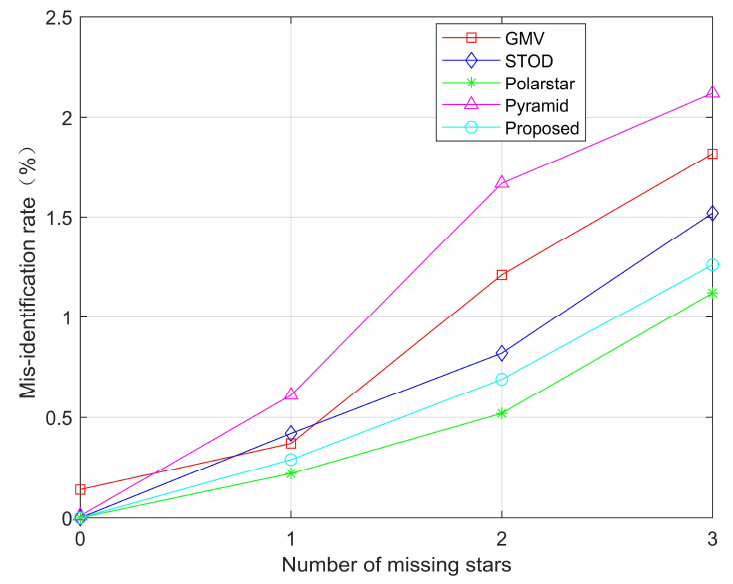
Figure 21. Misidentification rate benchmarking for sensitivity to missing stars.